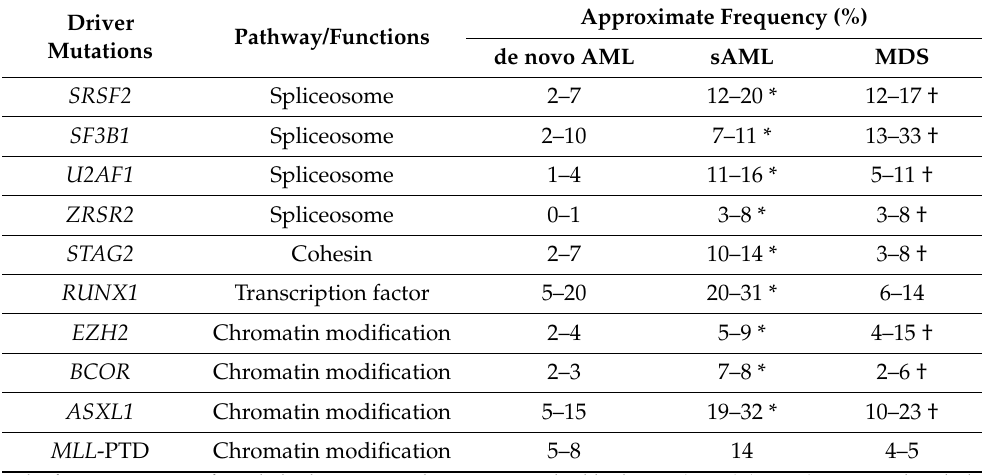
Table 1. Mutations defining chromatin-spliceosome acute myeloid leukemia